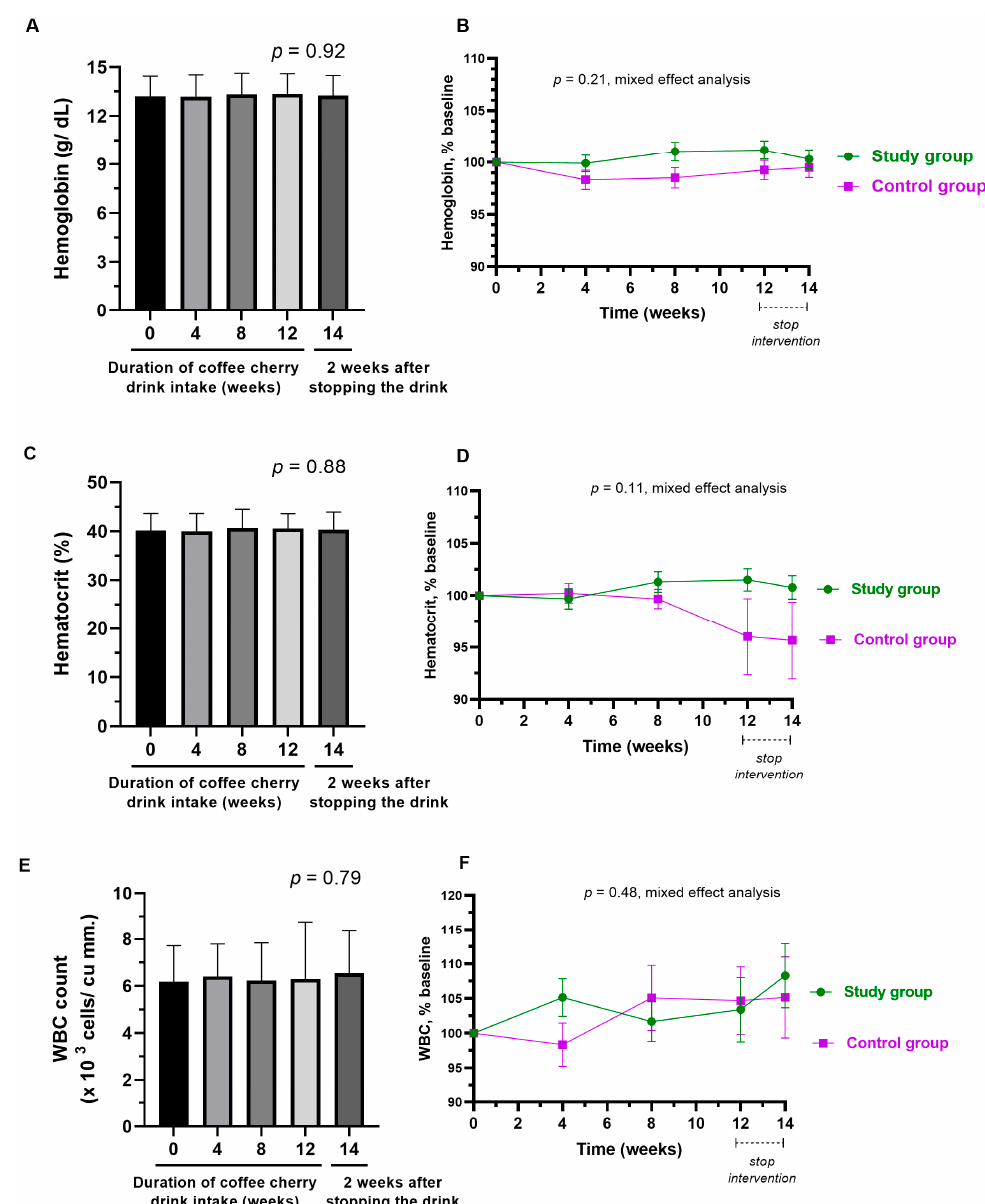
Figure 9. Changes in hemoglobin, hematocrit, and WBC. The bar graphs show the mean and standard deviation of hemoglobin ( A ), hematocrit ( C ), and WBC ( E ) after consumption of cherry coffee pulp juice concentrate for 4, 8, and 12 weeks, and 2 weeks after stopping the intervention (14 weeks), with p -value obtained from the Kruskal–Wallis test; the line graphs show a comparison of the mean and standard deviation of the hemoglobin ( B ), hematocrit ( D ), and WBC ( F ) in the percentage of the respective baseline values (% baseline) at each time point between study (green) and control (purple) groups, with p -value obtained from mixed-effect analysis.